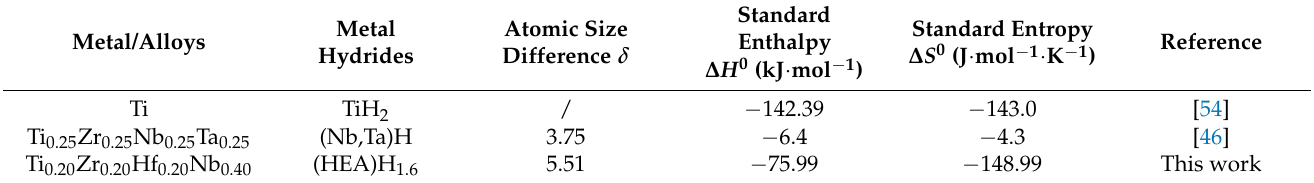
Table 5. Standard enthalpies and entropies of Ti and HEA